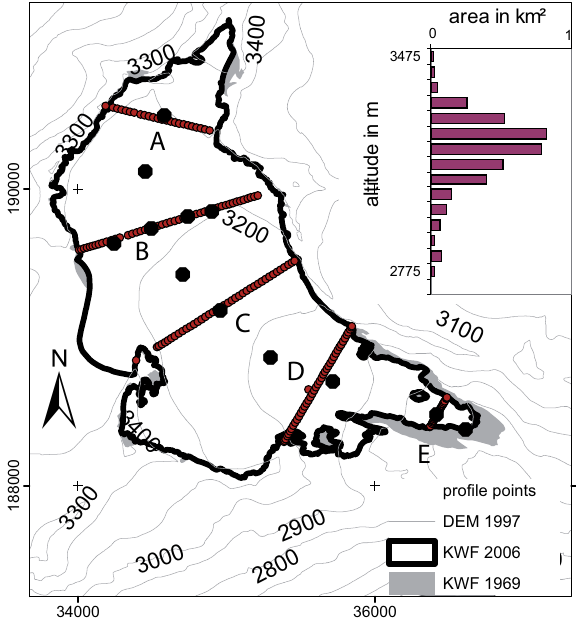
Fig. 6. Map of Kesselwandferner, ¨Otztal Alps, with profiles A to E (red dots) and position of stakes in 1997 (black dots).